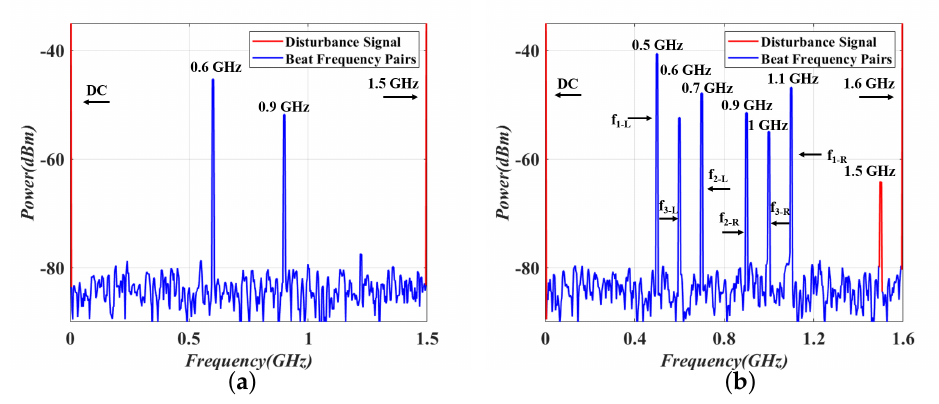
Figure 12. Receiving results for incoming signals at 2.1, 3.9 and 5.4 GHz, where the comb spacing is ( a ) 1.5 GHz and ( b ) 1.6